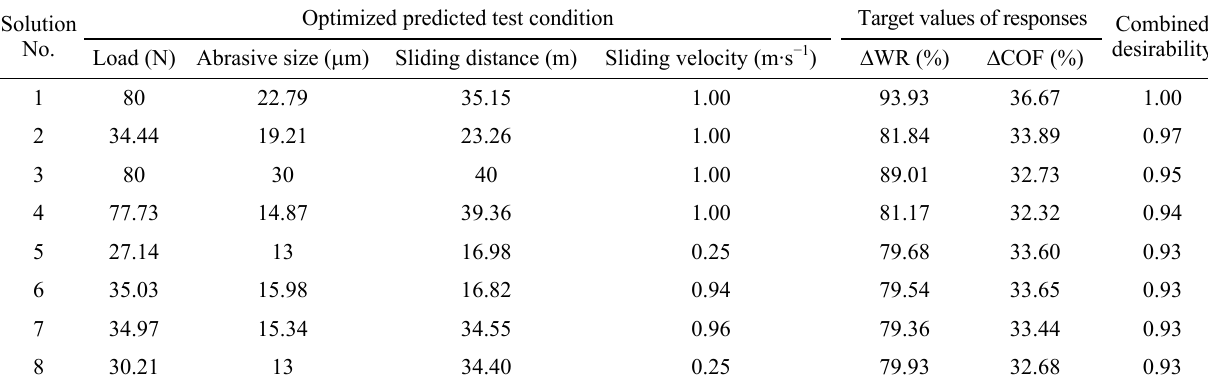
Table 7 Optimized predicted testing parameters with target output values based on desirability approach.